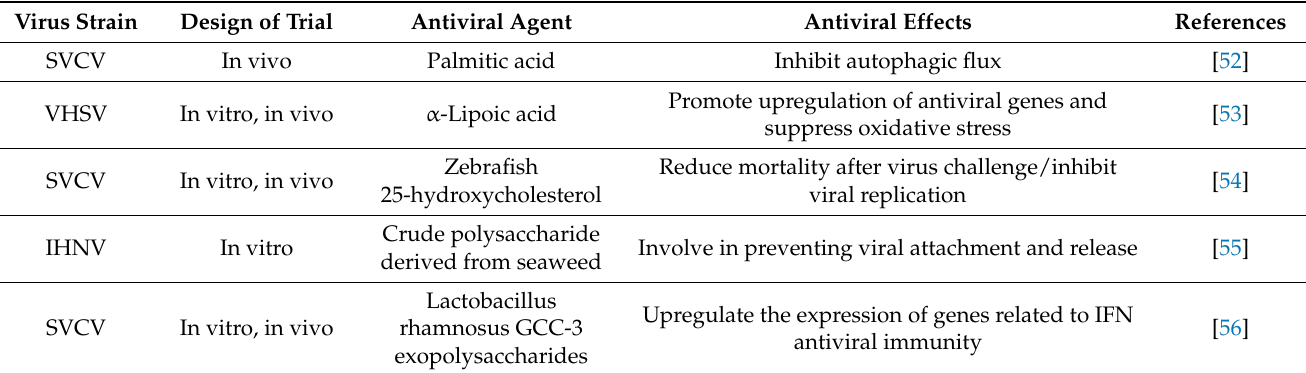
Table 4. Antiviral lipids and polysaccharides against fish rhabdoviruses and their antiviral effects. Virus